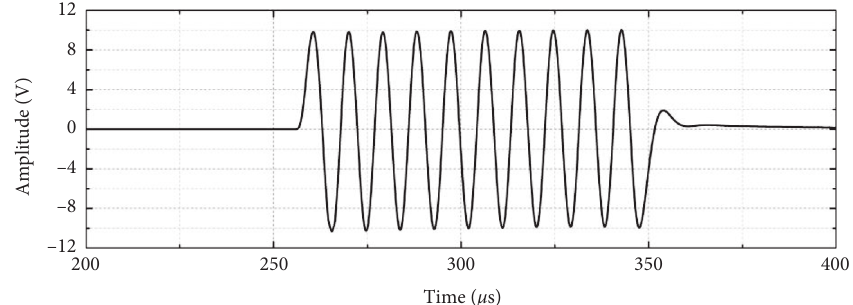
Figure 2: Transmitted